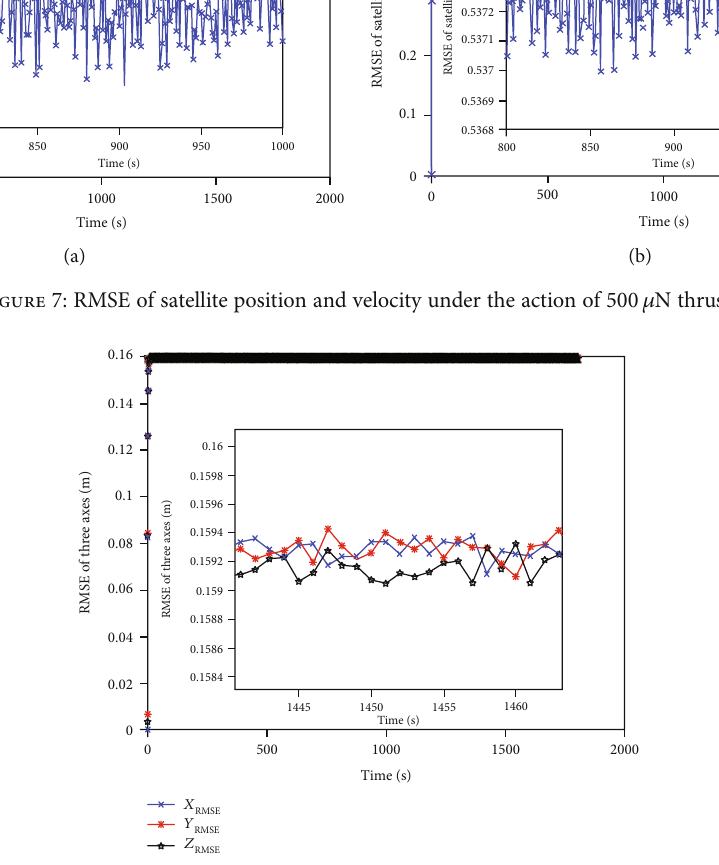
Figure 8: RMSE of a three-axis satellite under the action of 500 μ N